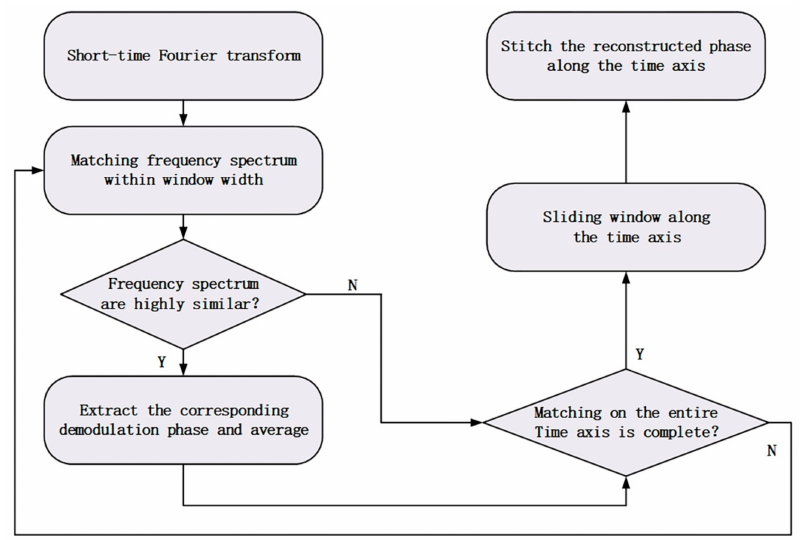
Figure 7. The process of judging using short-time Fourier transform (STFT) as a standard